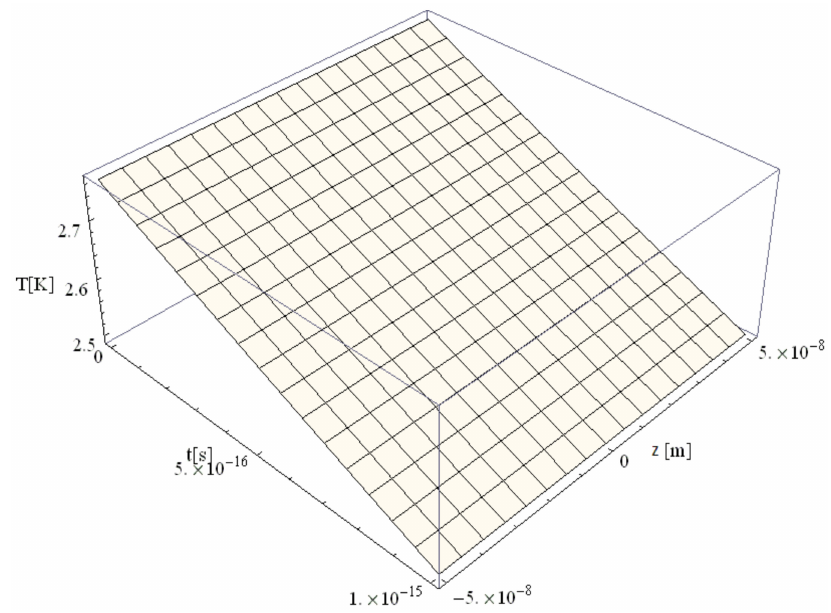
Figure 3. Electron temperature versus time and z during 1 fs simulation after irradiation with a 100 as laser pulse applied to an Au nanoparticle with a 50 nm